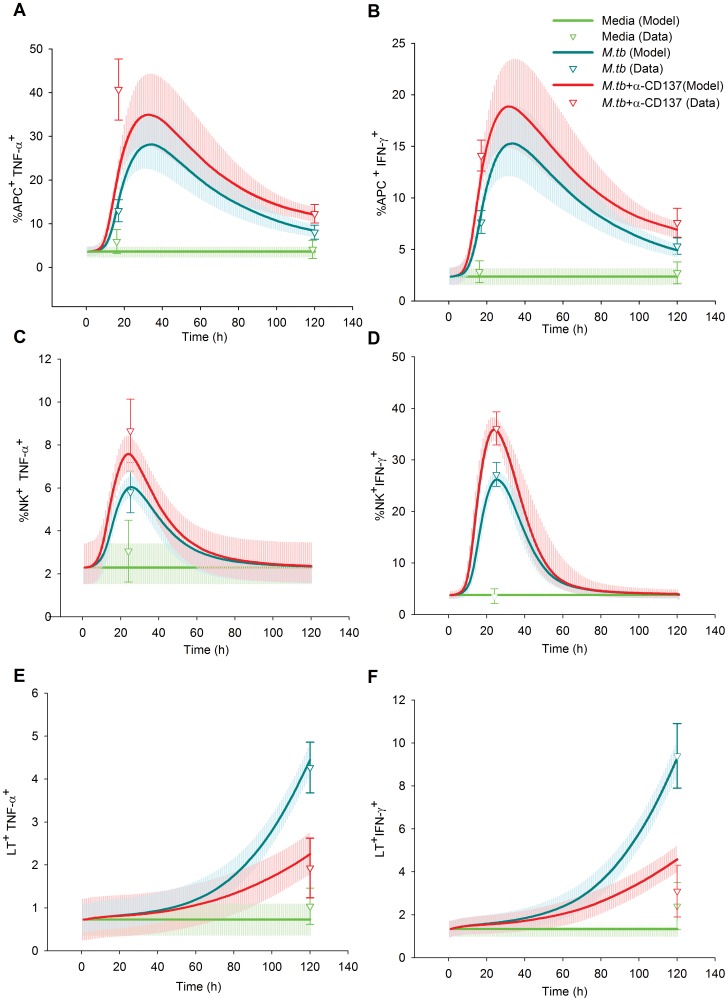
Effect of CD137:CD137L pathway on the immune cell cytokine production in tuberculosis.Different curves represent the best fit of our mathematical model to the data, the median and the 50% of the predictive posterior interval are shown. The mean of the experimental data is shown by triangles. Experimental data were obtained from PBMC of tuberculosis patients stimulated with M.tb Ag in the presence or absence of blocking anti-CD137 mAb. A–B; After 16 and 120 h, the intracellular expression of TNF-α (A) and IFN-γ (B) was determined by flow cytometry, by first gating on monocytes by light scatterand then by gating on CD14+ cells. Each represents the mean ± SEM of the percentage of CD14+cytokine+ cells for each group (11 individuals). C–D; PBMC were stimulated with M.tb Ag for 24 h in the presence or absence of blocking anti-CD137 mAb and intracellular TNF-α (C) and IFN-γ (D) expression on CD56bright NK cells was determined by flow cytometry by first gating on lymphocytes by light scatter, then by gating on CD3− cells and finally gating on CD56bright NK cells. Each triangle represents the mean ± SEM (10 individuals). E–F; PBMC were stimulated with M.tb Ag for 4 days in the presence or absence of anti-CD137 blocking mAb. Intracellular TNF-α (E) and IFN-γ (F) expression was determined by flow cytometry in T cells. Each triangles represents the mean ± SEM (16 individuals). Predictions were made according to the following equations (Supporting Information S1): A: R3, B: R2, C: R7, D: R6, E: R12, F: R11.